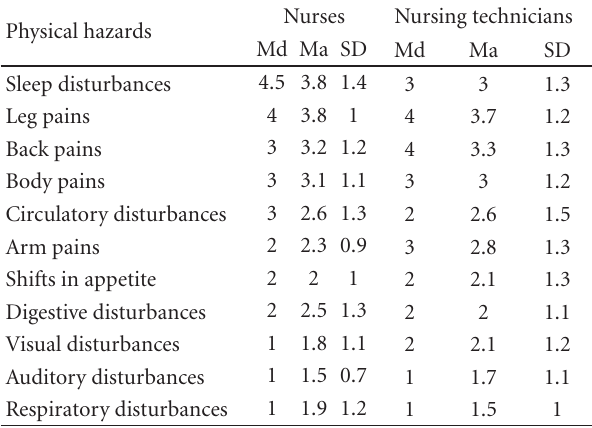
Table 4: Medians, means, and standard deviations of social damage among nurses and nursing technicians, Bras´ılia,